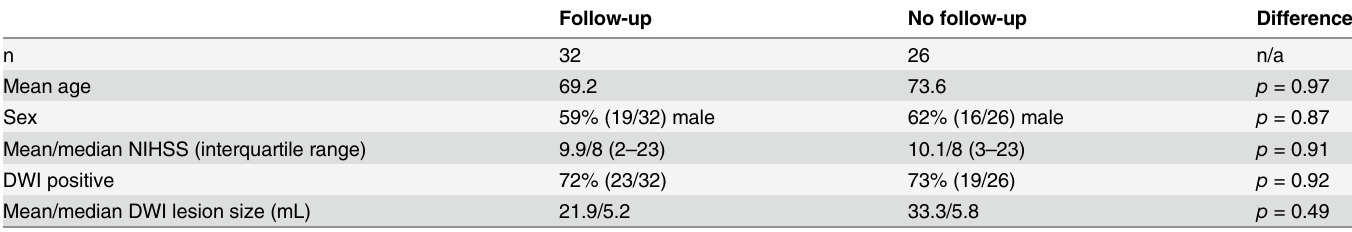
Table 1. Comparison of the subsets of patients who did and did not have follow-up examinations.